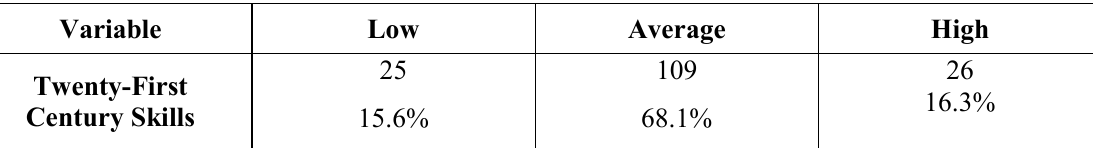
TABLE 1. LEVELS OF 21ST CENTURY SKILLS AMONG COLLEGE